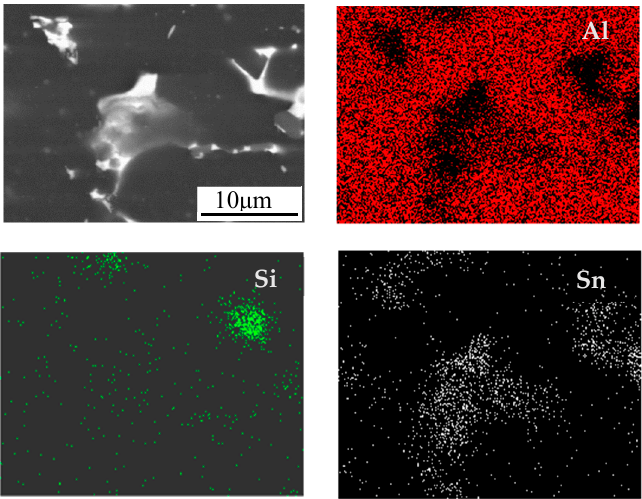
Figure 2. Surface SEM images and EDS map of Al-Sn alloy oxidized for 12 h at 25 °C. Surface morphologies of oxide films formed after 12 h at different temperatures as